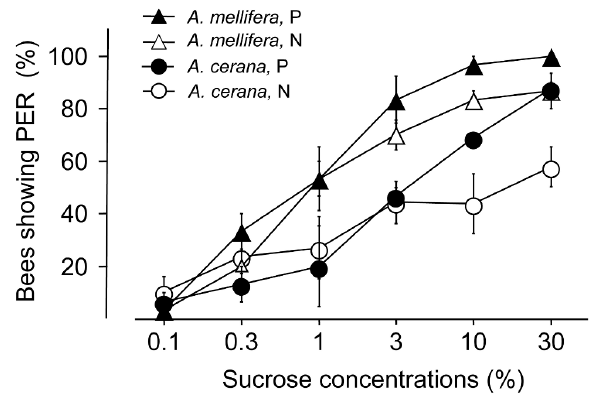
Figure 2. Percentage of bees showing proboscis extension response (mean+SE) of pollen (P, solid) and nectar (N, empty) foragers of Apis mellifera (triangles) and A. cerana (circles) of unknown-aged foragers in mixed- species colonies, across different sucrose concentrations (plotted as log scale but with actual concentrations). Data based on 3 mixed-species colonies (N = 3 x 2 x 2 x 10 = 120 bees).